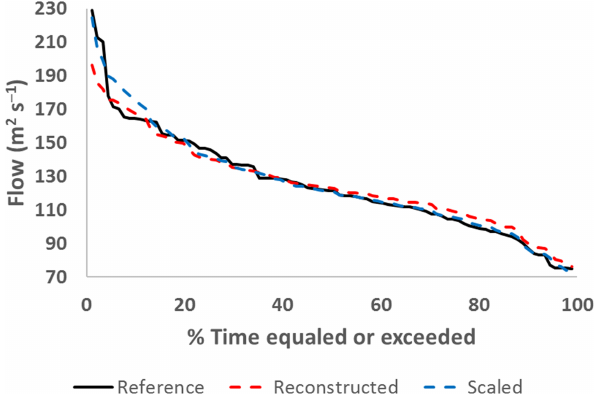
Figure 4. An example of a comparison between a yearly flow re- construction and yearly reference naturalized flow for the refer- ence period (1912–2001) for Bow River using a flow duration curve (FDC). A scaling method was used to scale the yearly flow recon- struction FDC so that it would have the same shape as the FDC of the yearly reference